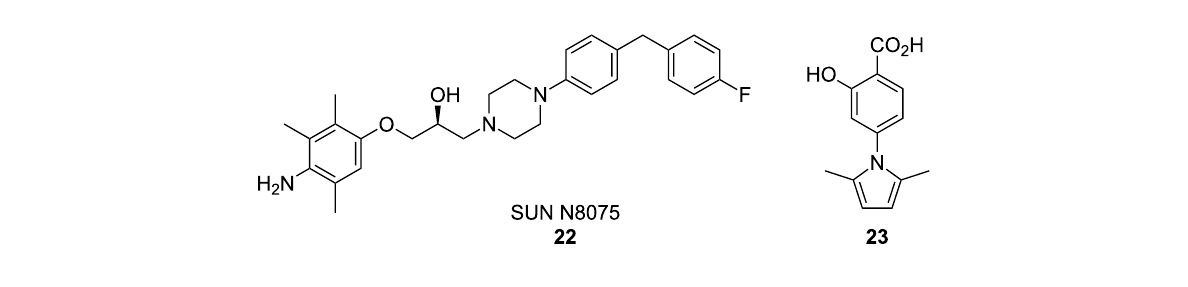
Figure 11: Compounds used to evaluate the effects of trophic factors on ALS disease progression.